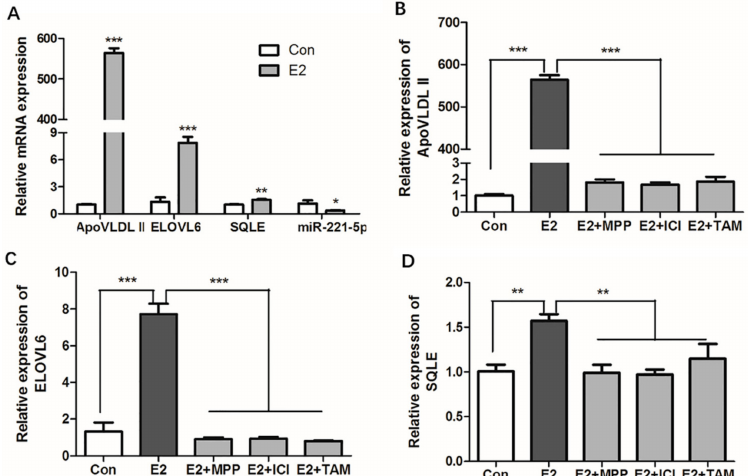
Figure 8. E ff ects of estrogen and estrogen antagonists on the expression of ApoVLDL II , gga-miR-21-5p, ELOVL6, and SQLE gene in vitro. ( A ) E ff ects of estrogen on the expression of ApoVLDL II , gga-miR-21-5p ELOVL6, and SQLE gene in vitro. ( B – D ) E ff ects of estrogen and estrogen antagonists co-treated on the expression of ApoVLDL II , ELOVL6, and SQLE gene in vitro. Con indicates control group, E2 indicates 17 β -estradiol (100nM) treated group, E2 + MPP indicates 17 β -estradiol (100 nM) and MPP co- treated group, E2 + ICI indicates 17 β -estradiol (100 nM), and ICI 182,780 co-treated group, E2 + TAM indicates 17 β -estradiol (100 nM), and tamoxifen co-treated group, respectively. β -actin was used as an internal reference gene. Data are represented as mean ± SD ( n = 6). * means 0.01 < p < 0.05, ** means 0.001 < p < 0.01, *** means p < 0.0001.